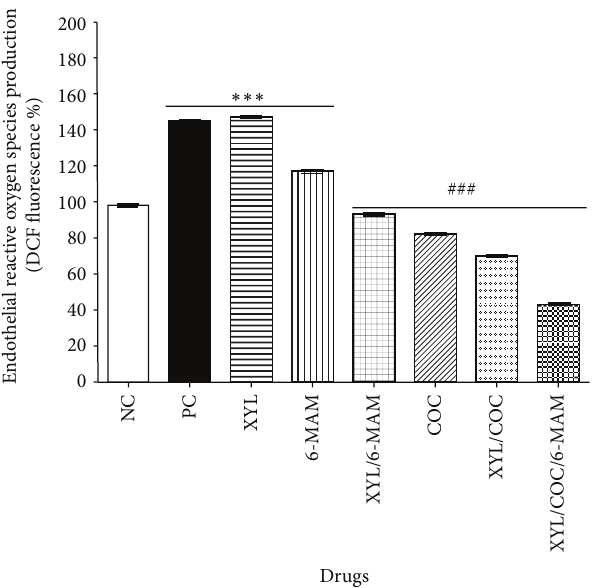
Figure 1: Effect of xylazine, cocaine, 6-monoacetylmorphine, and their combination on ROS production in human umbili- cal vein endothelial cells (EA.hy926). ROS levels in EA.hy926 cells, after 24 h of exposure to negative control (vehicle), xylazine (XYL, 60 𝜇 M), cocaine (COC, 160 𝜇 M), 6-monoacetylmorphine (6- MAM, 160 𝜇 M), camptothecin (positive control, 50 𝜇 M), XYL/COC (50 𝜇 M), XYL/6-MAM (50 𝜇 M), and XYL/COC/6-MAM (40 𝜇 M), were determined. Cells exposed to XYL and 6-MAM showed increased ROS levels. Cells exposed to COC and XYL in combi- nation with COC and 6-MAM showed diminished ROS levels in comparison to negative control as determined by ANOVA. The experiment was repeated for at least three times in replicates and expressed as change from negative control (%). All values are expressed as mean ± SD of 6–9 replicates, from 2 to 3 experiments. Statistical analysis performed was a one-way ANOVA, with Tukey post hoc test, where 𝑃 < 0.05 was considered to be significant. 𝑃 summary; ∗∗∗ significantly higher in contrast to the negative control ( 𝑃 < 0.0001 ), ### significantly lower in contrast to the negative control ( 𝑃 < 0.0001